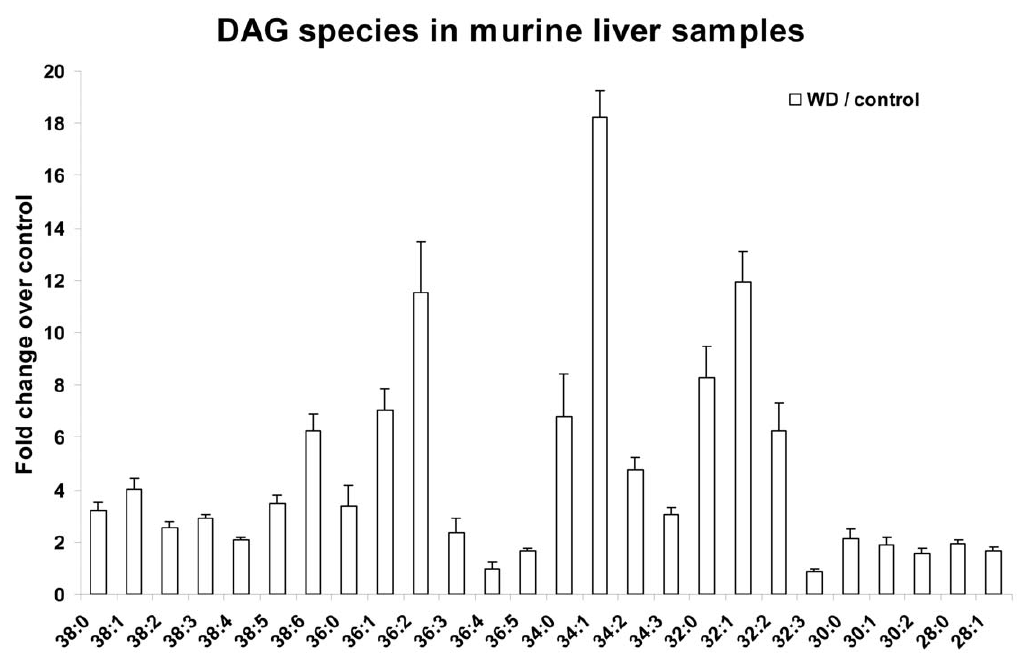
Figure 4. Fold changes in diacylglycerol (DAG) species from murine livers. Fold changes (WD/control) in DAGs from murine tissues. All fold changes in panel B are significant with p , 0.024 except for 36:4; n=3 individuals per group.